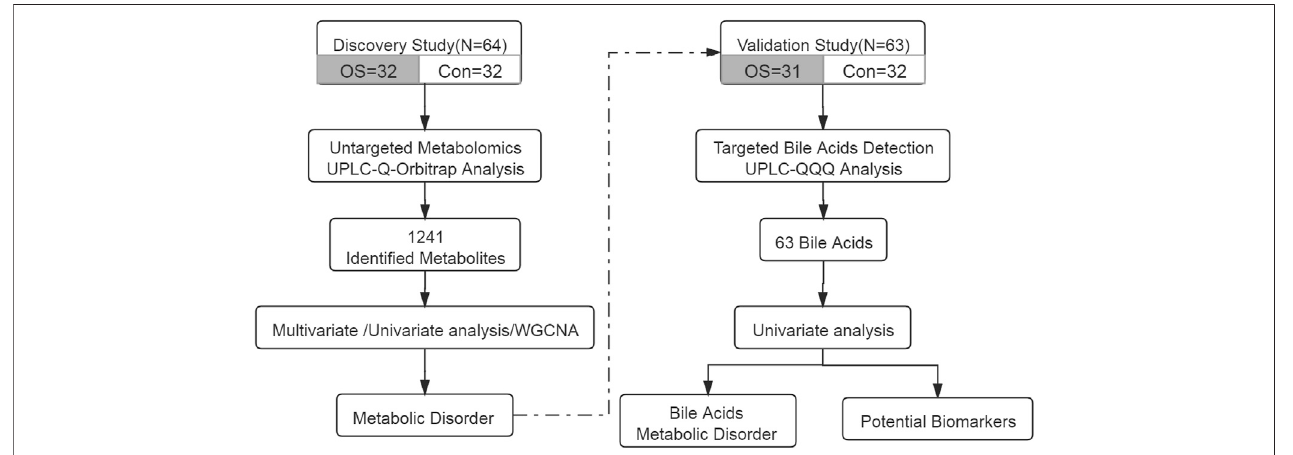
FIGURE 1 | The design and work fl ow of this